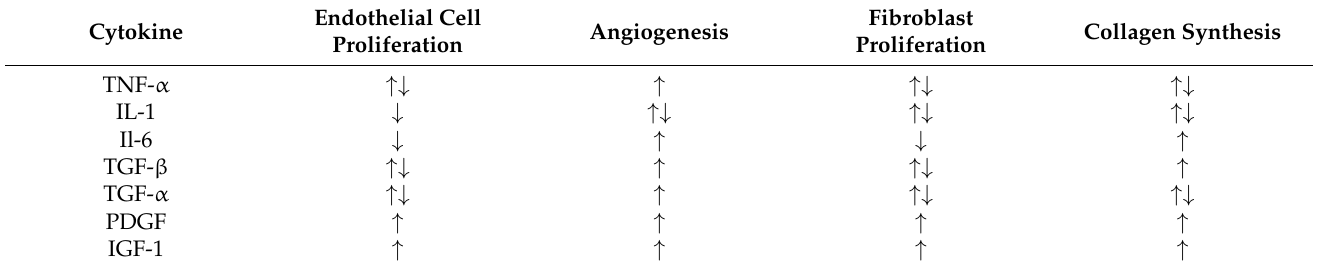
Table 1. Cytokines secreted by macrophages, and their functions. The symbol ↑ represents increase, while ↓ represents decrease. The details are adapted from